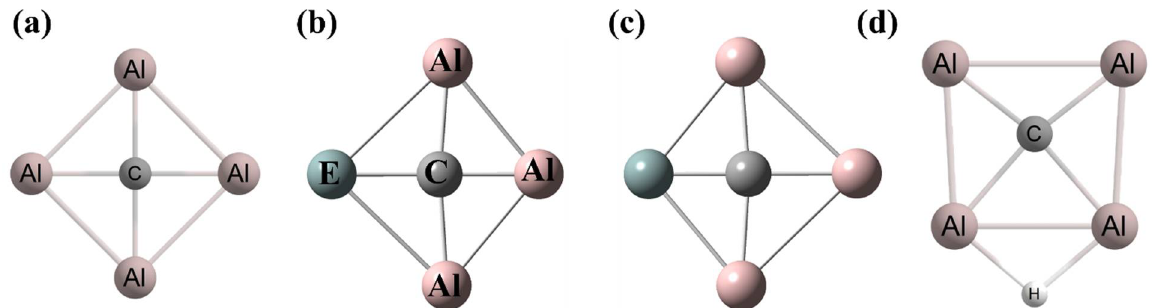
Figure 17. The optimized structures of ( a ) CAl 4− , ( b ) CAl 3 E (E = Si, Ge) ( C 2 v -I) and CAl 3 E − , and ( c ) CAl 3 E (E = Si, Ge) ( C 2 v -II) clusters. The global minimum structures of ( d ) CAl 4 H and CAl 4 H − clusters. For ( b , d ) structures, the neutral and anionic forms have the same shape but different bond lengths.